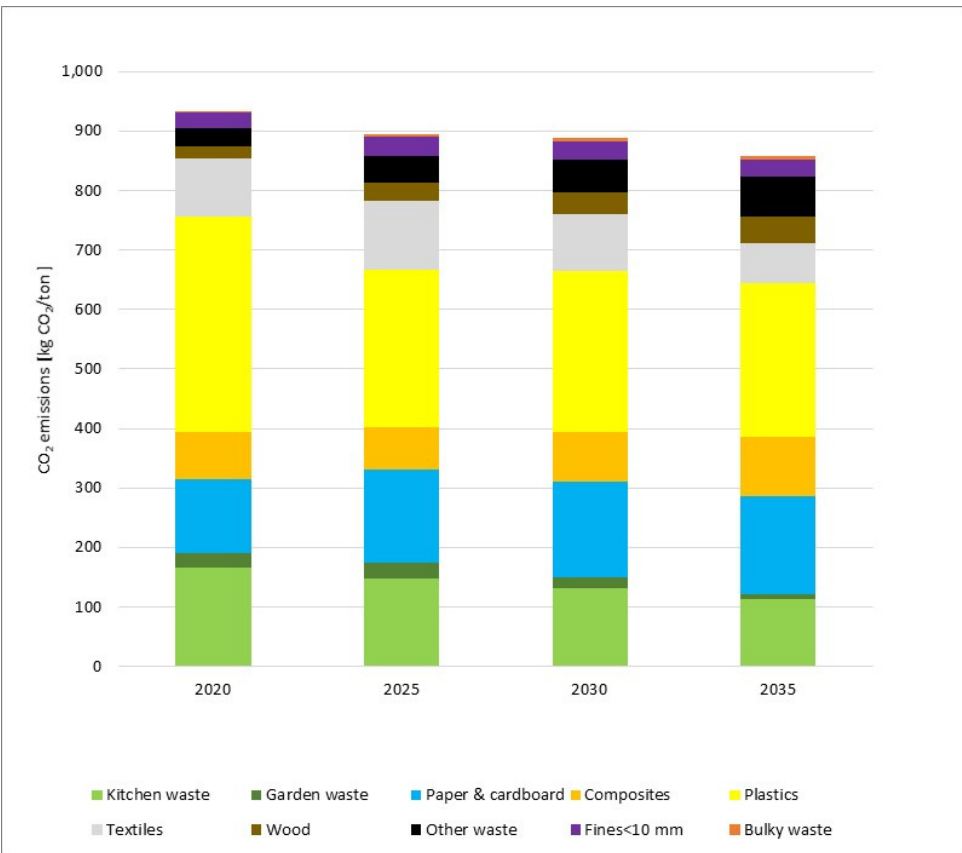
Figure 16. CO 2 emissions from residual waste combustion in the period 2020–2035.